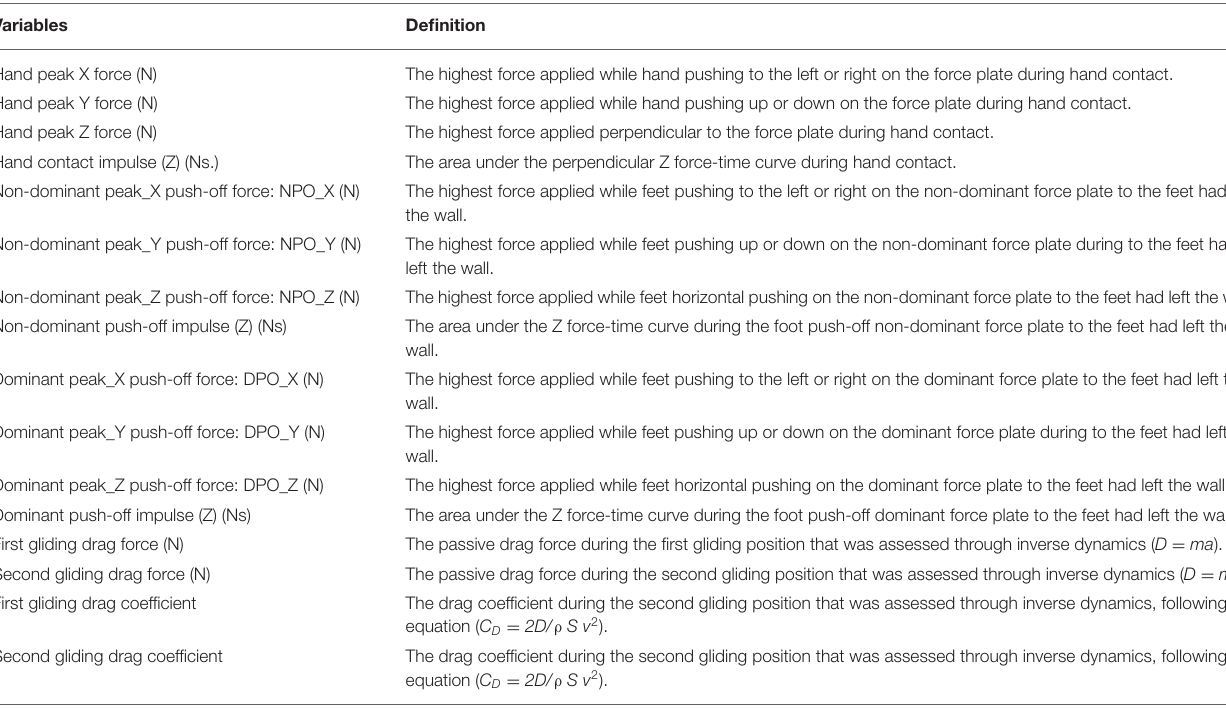
TABLE 2 | Kinetic and hydrodynamic variables selected for analyzing the backstroke to breaststroke turns. Variables Definition Hand peak X force